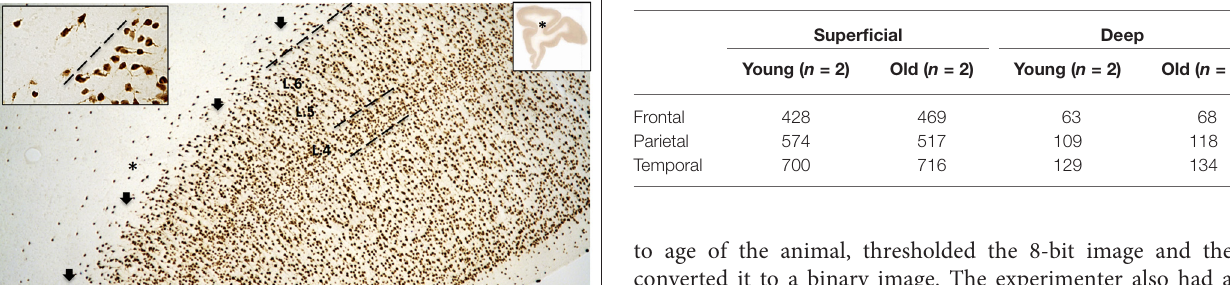
TABLE 2 | Numbers of neurons used for morphometric analysis